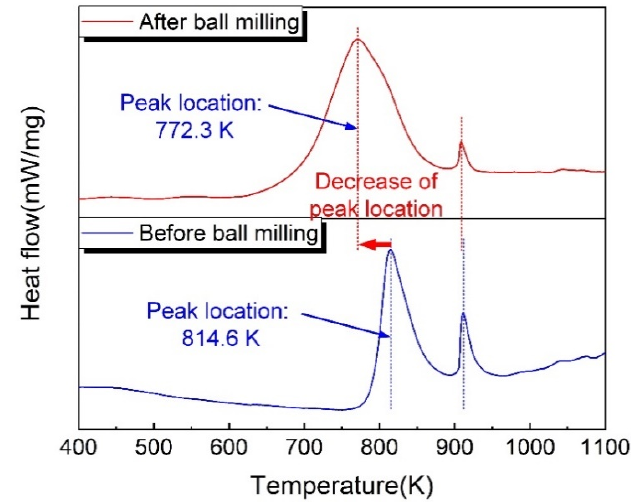
Figure 6. DSC curves of the Al/Ni energetic composites.